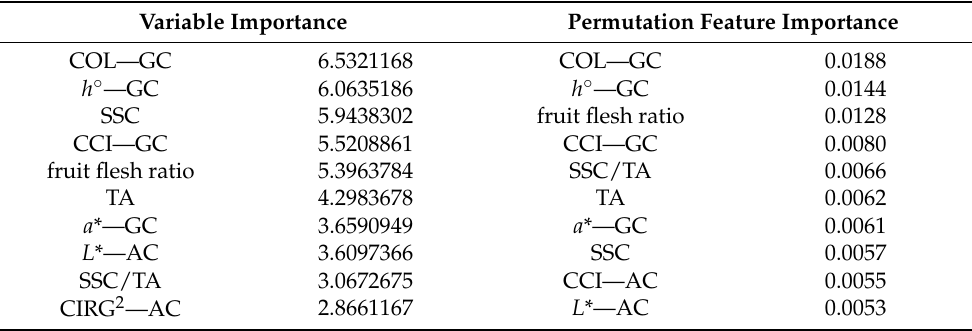
Table 6. Top 10 most contributing variables in the ROSE balanced Model C dataset.